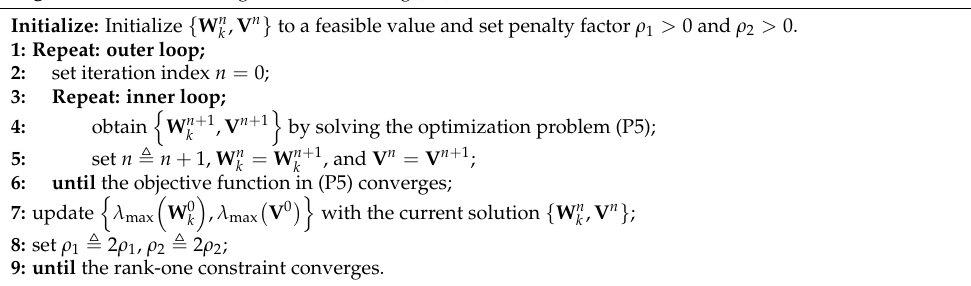
Algorithm 1 : Altmin-1 Algorithm for Solving